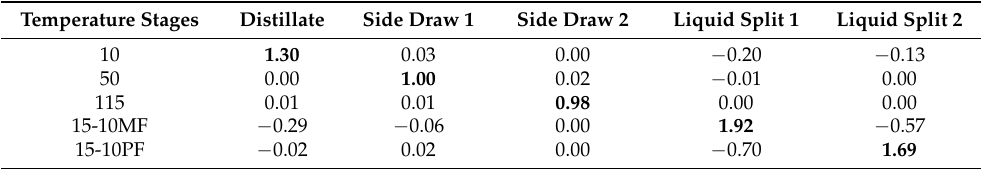
Table 4. RGA analysis for mixture 1.